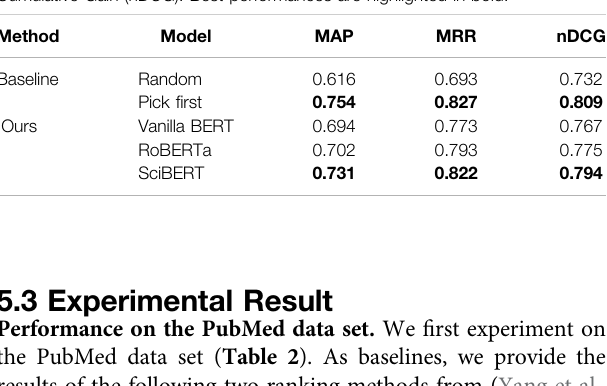
TABLE 3 | Performances of vanilla BERT, RoBERTa, and SciBERT against the random and pick fi rst baselines on CS papers. We report Mean Average Precision (MAP), Mean Reciprocal Rank (MRR) and Normalized Discounted Cumulative Gain (nDCG). Best performances are highlighted in